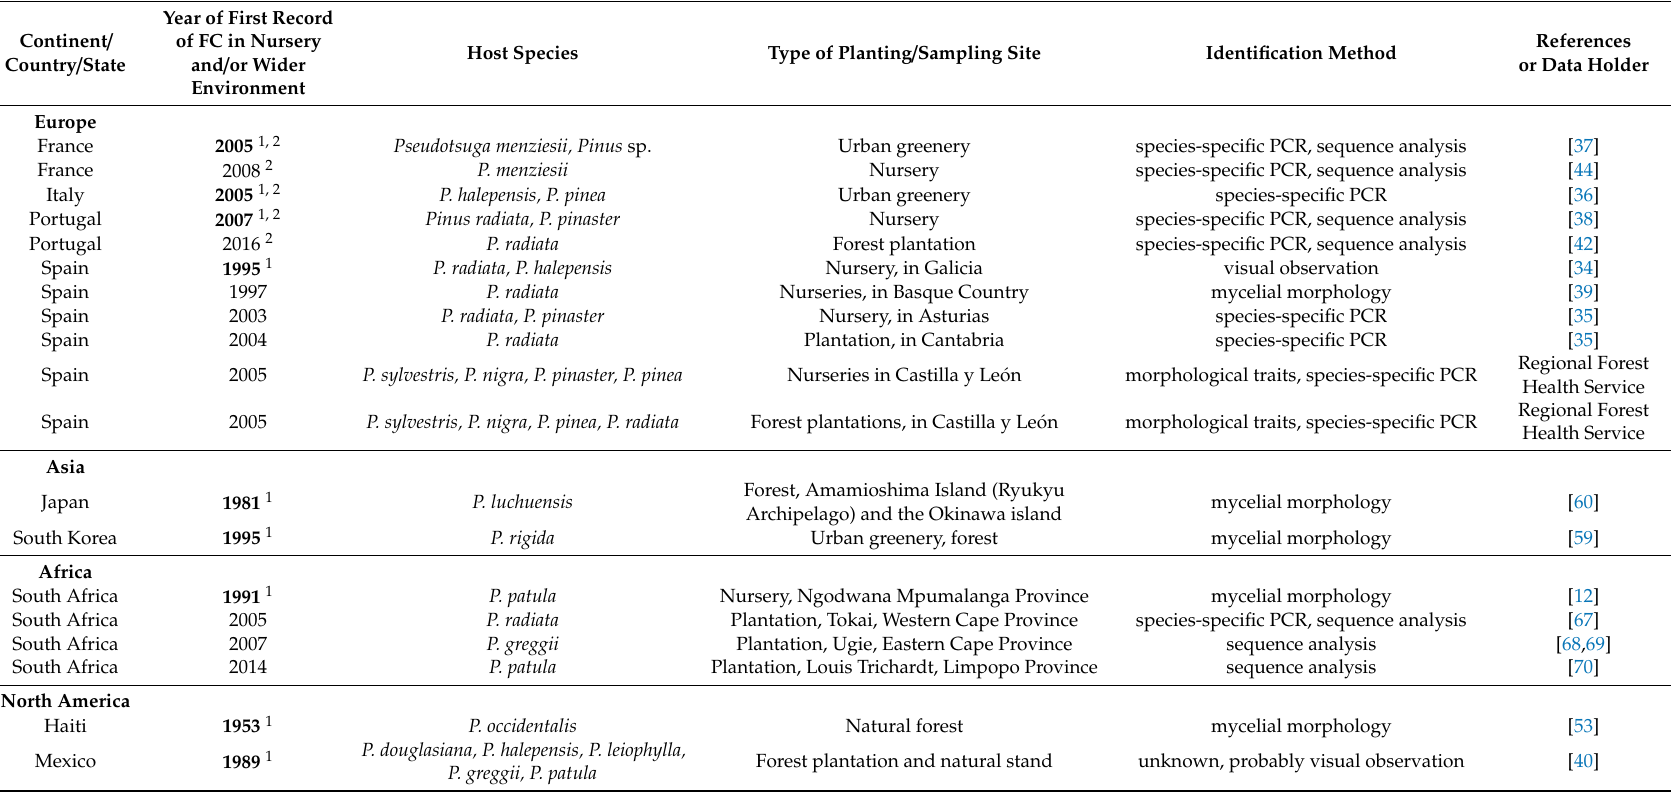
Table 1. Geographic distribution, by country, of Fusarium circinatum (FC) including the type of planting, year found, host species a ff ected, and the method used to identify the